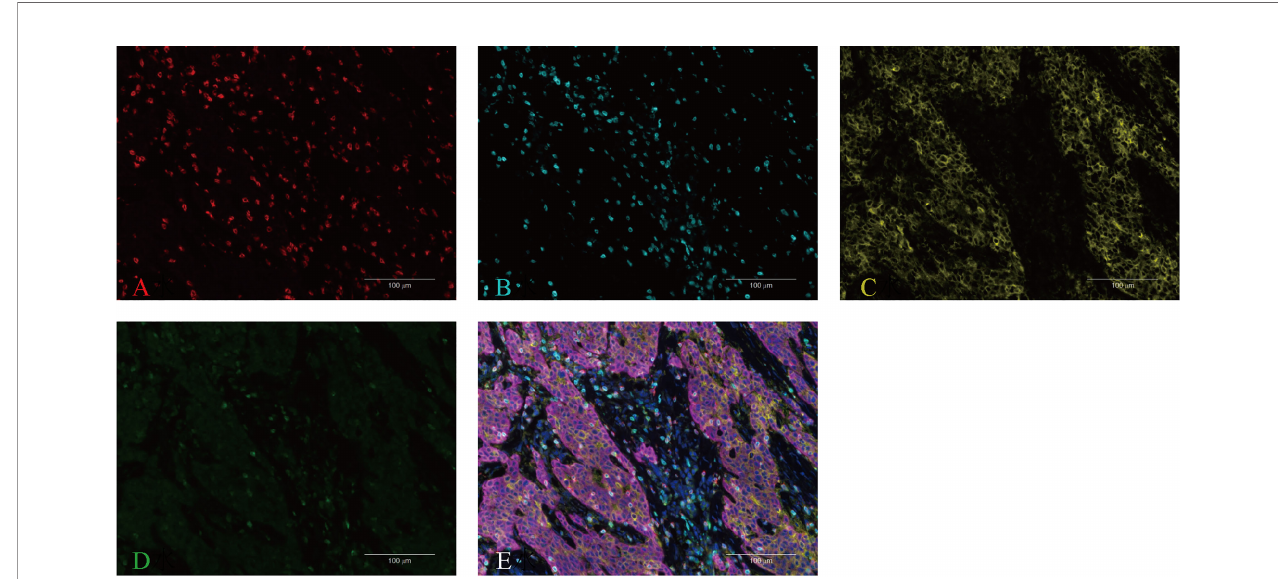
FIGURE 4 | Multiplex immuno fl uorescence staining for CD8 (A) , CD3 (B) , PD-L1 (C) , PD-1 (D) , and the merged image (E) in the primary tumor tissue. The multiplex IHC platform, which can detect the expression of multiple markers in a single section, was utilized to measure the expression of PD- 1/PD-L1 and immune cell in fi ltration. The immune markers included CD8+ TIL and CD3+